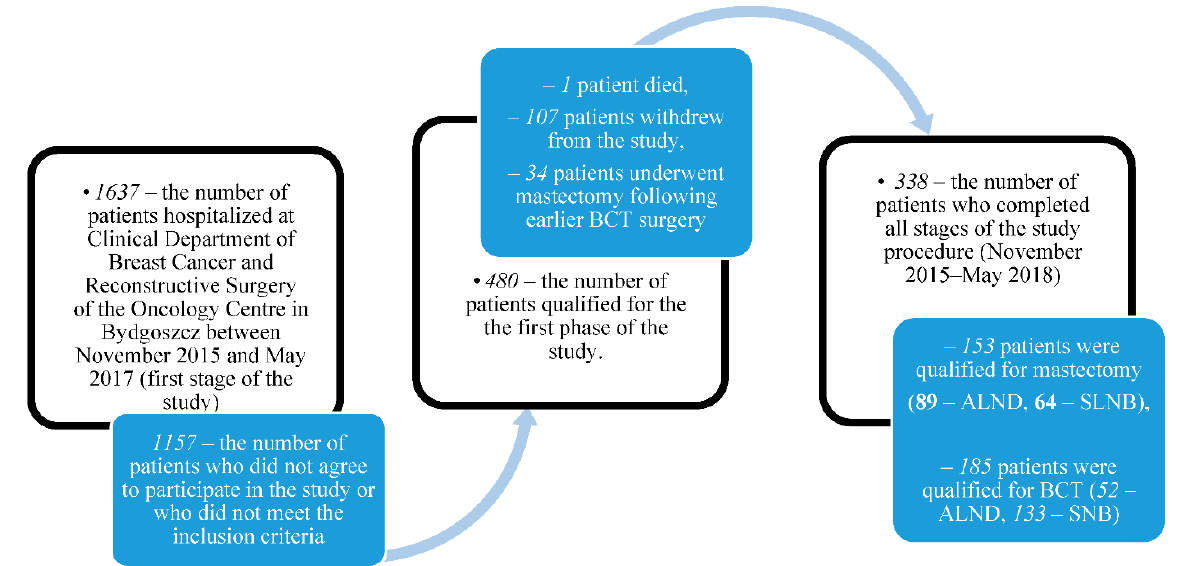
Figure 1. Scheme describing the exclusion of patients from the study.